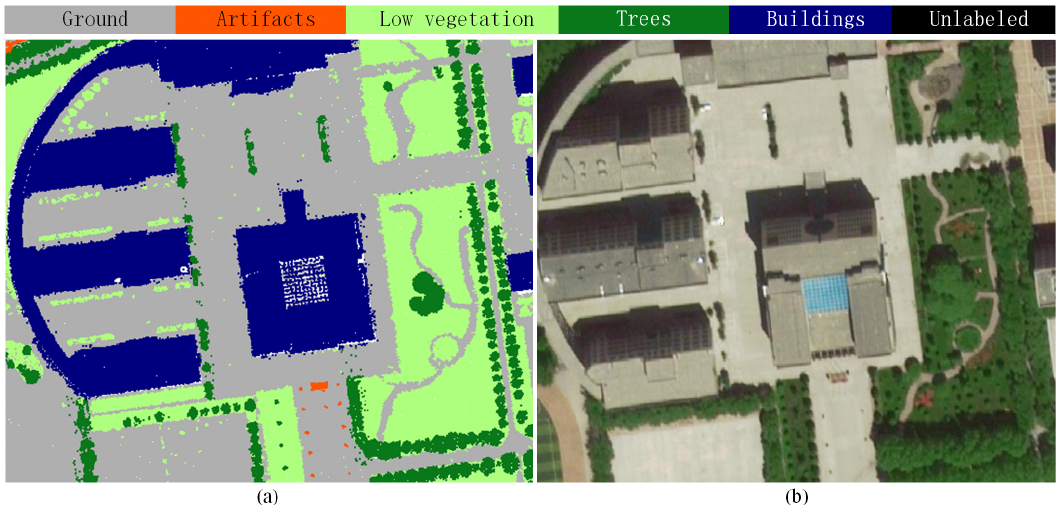
Figure 8. An example of the unchanged area in the test area. ( a ) ALS point cloud. ( b ) Satellite image of the same area.